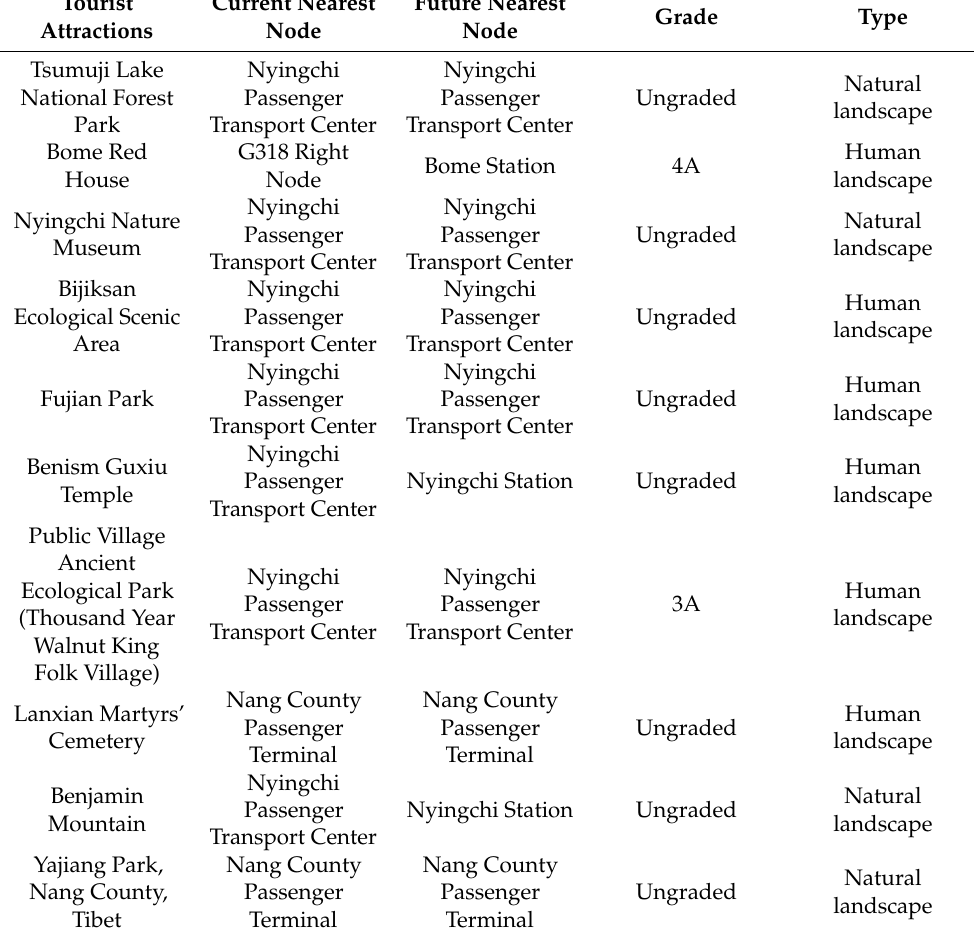
Table 7. The top 10 scenic tourist attractions’ route length within 10 km from traffic